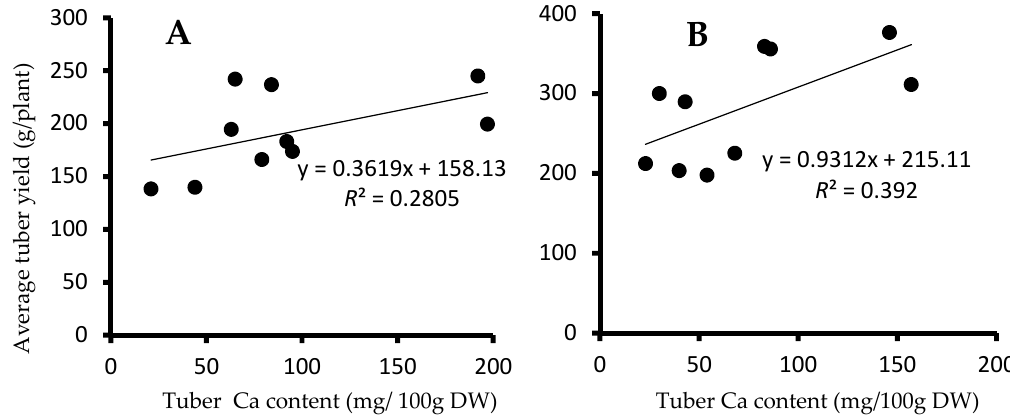
Figure 5. Correlation between average tuber yield per plant and tuber calcium content in the Shenkola ( A ) and Gera ( B ) potato varieties.